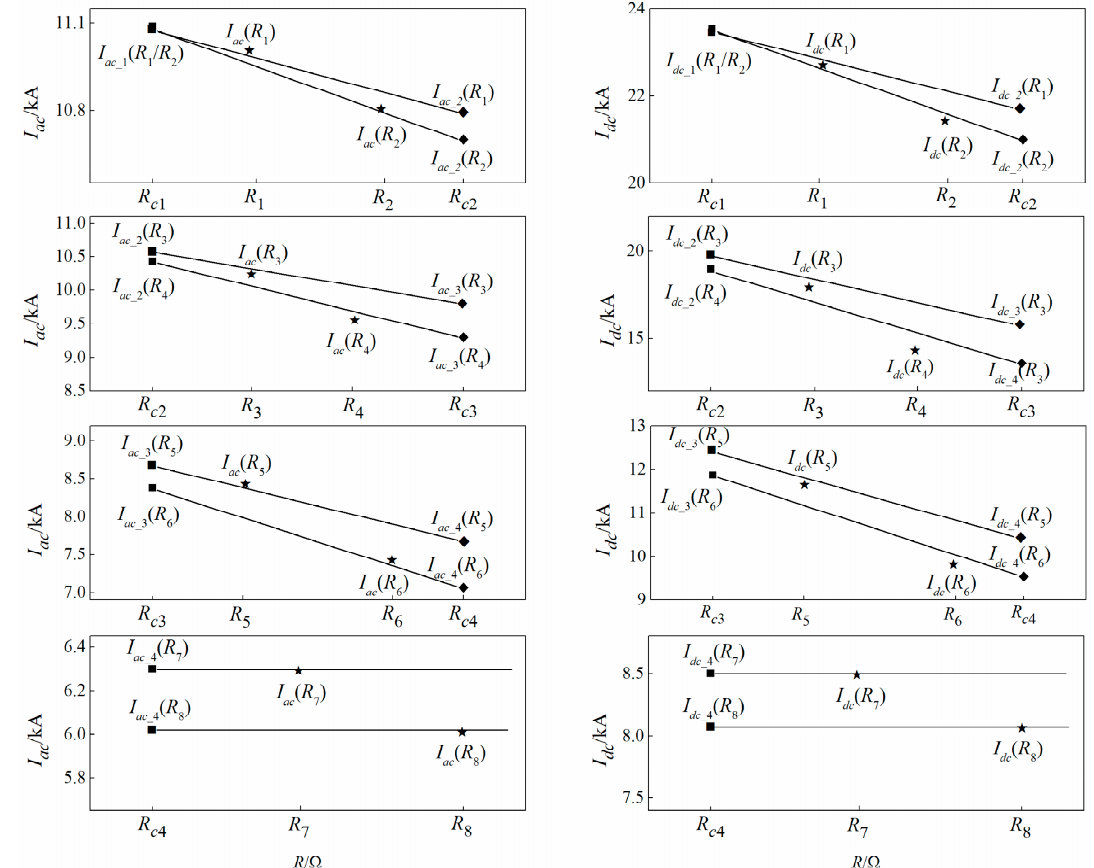
Figure 10. Comparison between the simulation results and calculation results.